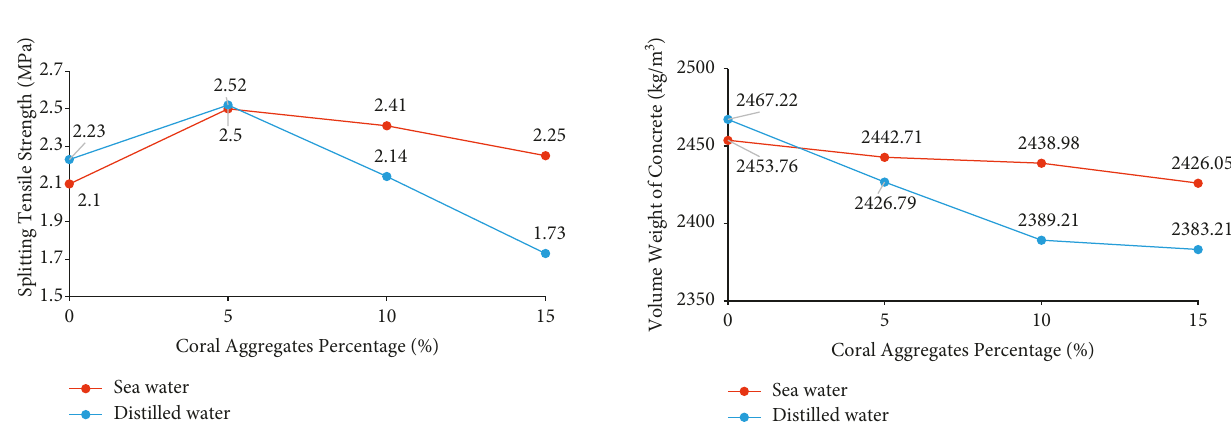
Figure 7: Splitting tensile strength of CA-concrete. Figure 8: Volume weight of coral aggregates